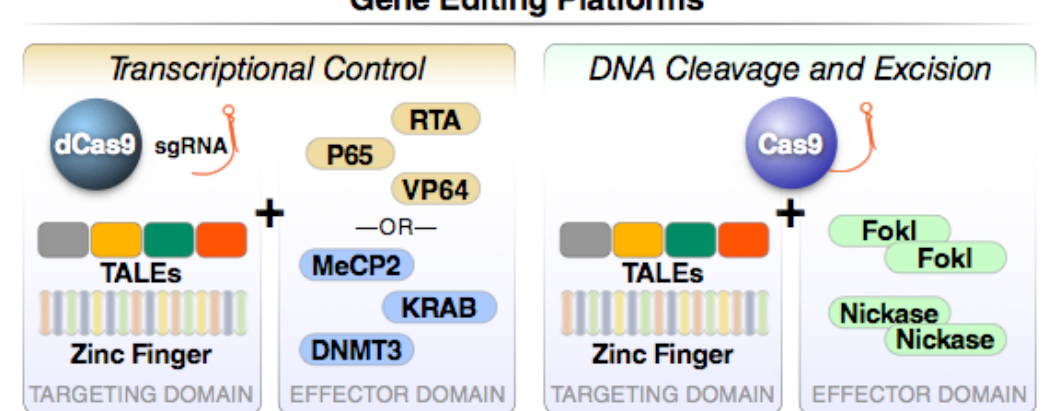
Figure 4. Major gene editing platforms operating through transcriptional control or DNA cleavage and excision. Two functions are present in all gene editing platforms. The first component directs sequence-specific DNA binding while the second promotes either frank DNA cleavage or the recruitment of epigenetic modifiers that positively or negatively control target gene transcription. For example, a catalytically inactive or dead version of Cas9 (dCas9) can be fused to a strong transcriptional activation domain from the RelA transcription factor (NF- κ B p65), the replication and transcription activator (RTA), or repeats of the HSV VP16 protein (VP64), to induce transcriptional activation. Alternatively, transcriptional inhibition can be induced by fusing dCas9 to Krueppel- associated box (KRAB) proteins, methyl CpG binding protein 2 (MeCP2), or DNA methyl transferase 3A (DNMT3a). These “baits” effectively recruit transcriptional repressors that silence gene activity via epigenetic mechanisms.